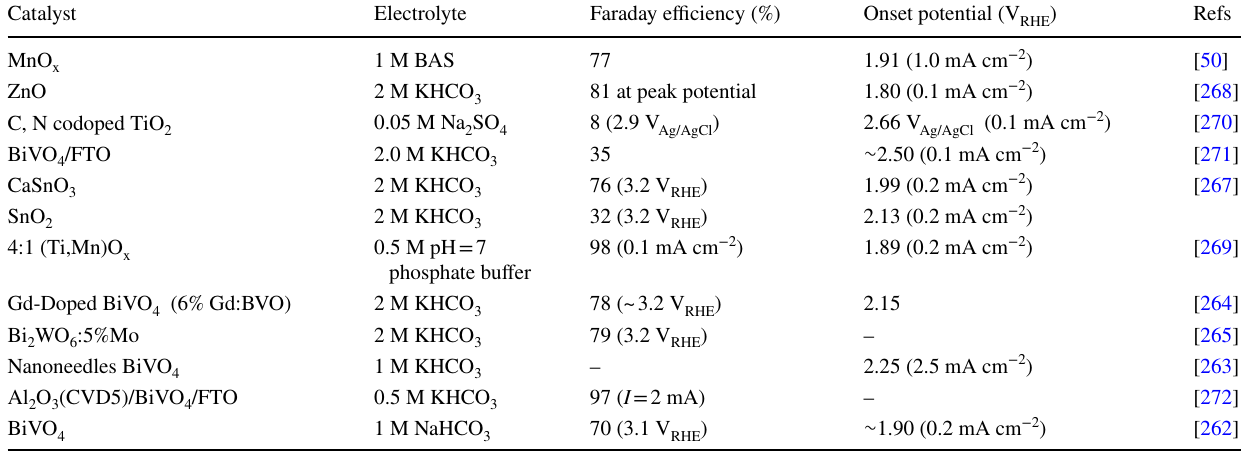
Table 4 Summary of electrocatalytic H 2 O 2 production via a 2e − WOR pathway Catalyst Electrolyte Faraday efficiency (%)